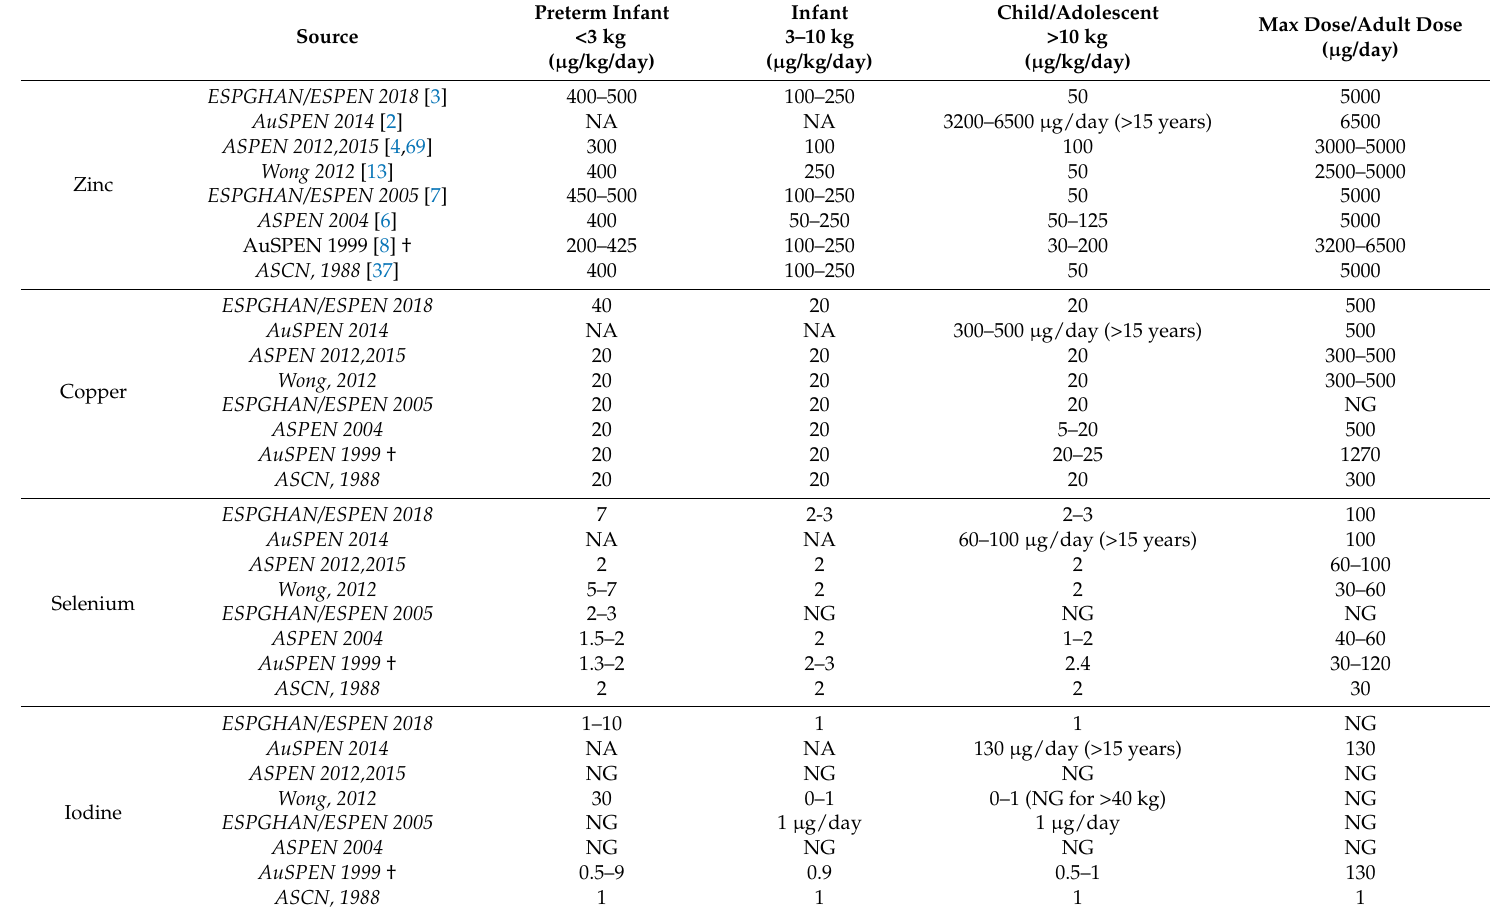
Table 1. Comparative summary of recommendations for trace element supplementation in paediatric parenteral